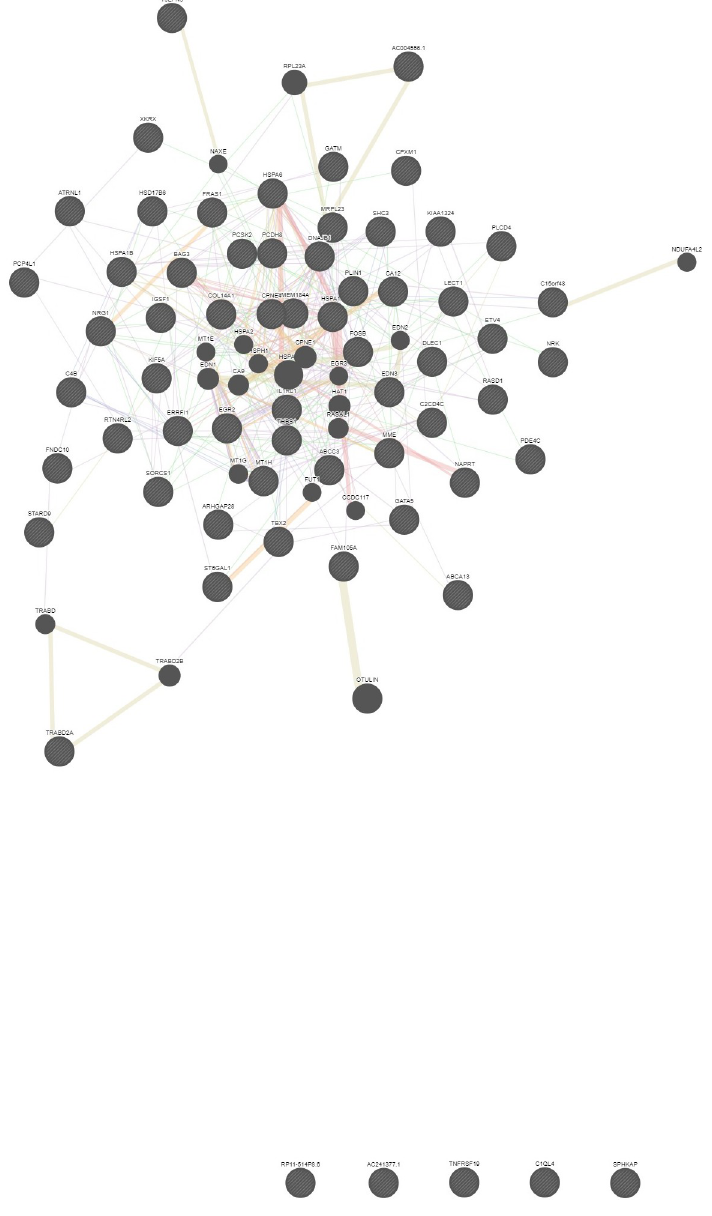
Fig 2. Protein-protein interaction analysis of 63 differentially expressed functional genes using the GeneMANIA software. A total of 423 gene interactions (more than 50% co-expression) of the five genes (TNF-RSF19, AC2413771 (HOTS gene), RP11-514P8.6, C1QL4, and SPHKAP) had no interactions identified with the others.